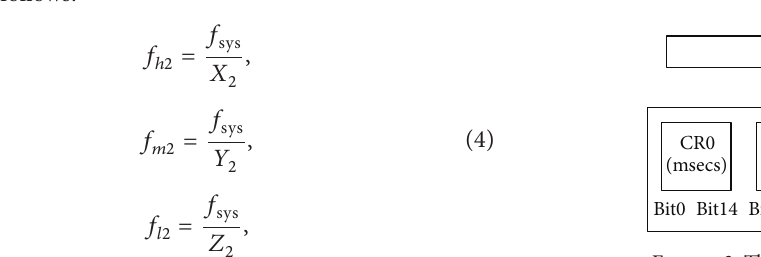
Figure 3: The real-time sleep timer